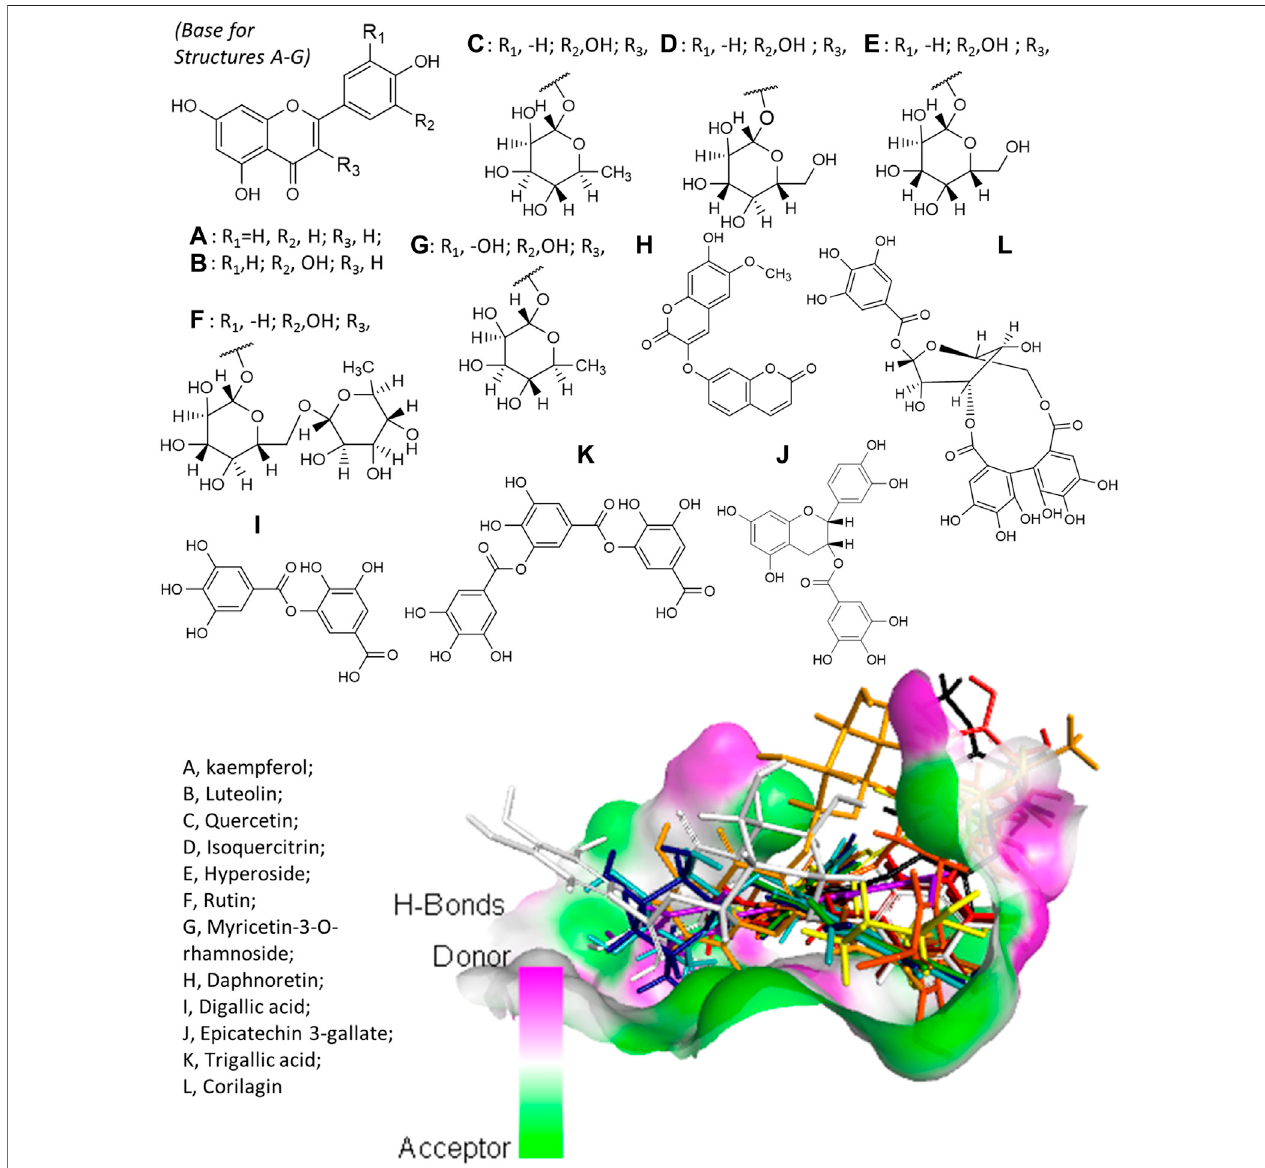
FIGURE 2 | Structures of the antiviral compounds found in E. hirta and overlain stick representation of the ligands in complex with SARS-CoV-2 Mpro. (A) Brown; (B) purple; (C) mint green; (D) cyan; (E) blue; (F) gold; (G) yellow; (H) black; (I) maroon; (J) orange; (K) red; and (L) gray.